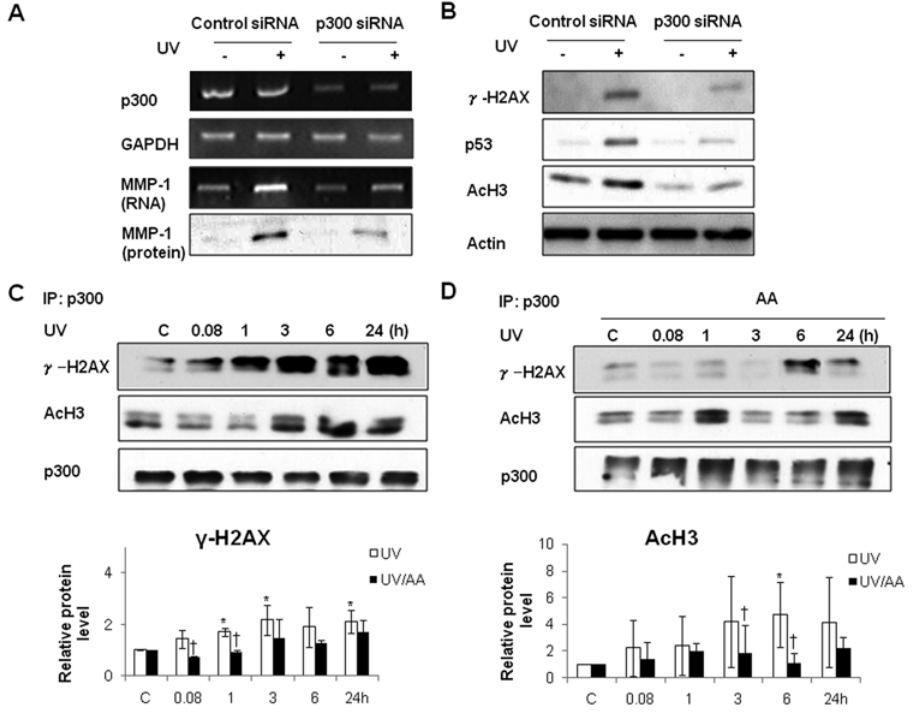
Figure 4. p300 siRNA suppressed UV-induced MMP-1 expression and inhibited UV-enhanced levels of c -H2AX, p53 and acetyl-H3, and AA inhibited interaction of p300 with c -H2AX or acetyl-H3 after UV. HDFs were transfected with scrambled control siRNA and p300 siRNA at 100 nM using Lipofectamine as recommended by the manufacturer. A, HDFs were irradiated with UV and incubated at 37 u C 24 h after transfection with scrambled control or p300 siRNA. The MMP-1 mRNA level was analyzed by RT-PCR and the amount of MMP-1 protein was analyzed by western blot. B, The effect of p300 siRNA on the protein levels of c -H2AX, p53, and acetyl-H3 were analyzed by western blotting. C, HDFs were UV- irradiated. After 6 h, whole cell lysates were immunoprecipitated with anti-p300 antibody. D, HDFs were UV-irradiated and post-treated with AA for 6 h. Whole cell lysates were immunoprecipitated with anti-p300 antibody. Proteins were immunoblotted with anti-p300, anti-acetyl-H3, and anti- c - H2AX antibodies ( upper panels ). Bar graphs ( lower panels ) show quantitative analysis of scanning densitometric values of c -H2AX, p53, and acetyl-H3 as ratios to b -actin, which was used as a loading control. Data shown are representative of three independent experiments. C: control, UV: UV- irradiated cells, AA: AA treated cells, UV/AA: UV irradiated cells incubated with AA. *P , 0.05 vs. control, { P , 0.05 vs.